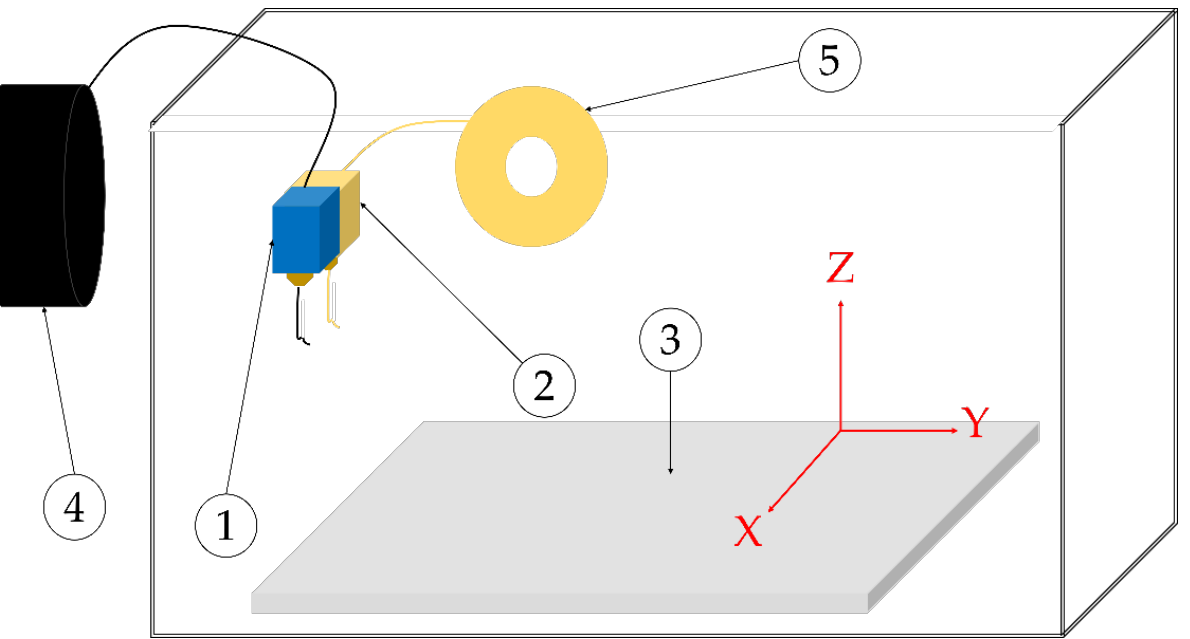
Figure 1. Scheme of Mark Two™ principal components. (1) Matrix nozzle. (2) Reinforcement nozzle. (3) Printing bed. (4) Matrix filament. (5) Reinforcement filament.